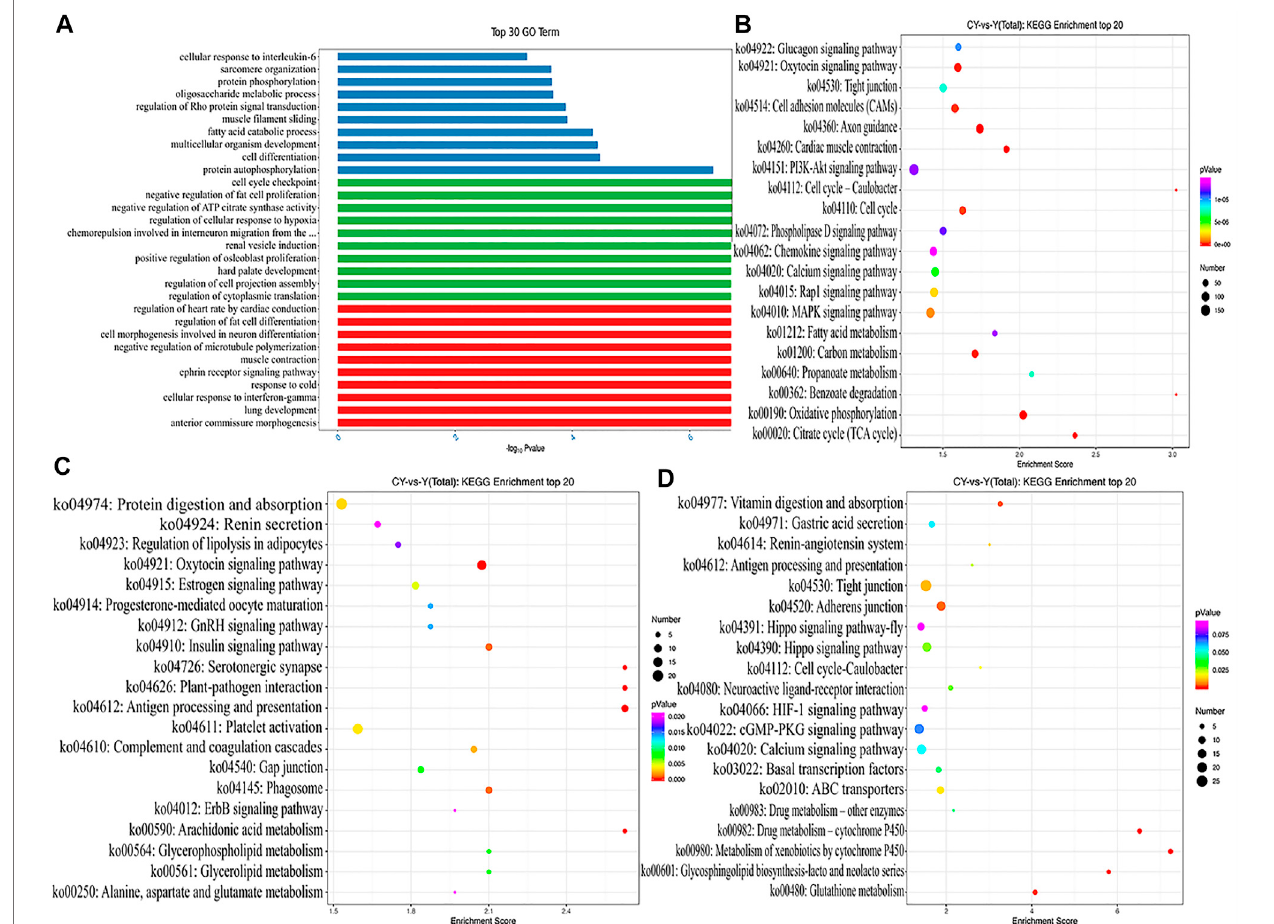
FIGURE3 | (A) GOanalysiswiththe top 10 enrichmentbiological processes for DEMs, DELs targets, and DECs host genes between cattle-yaks and yaks. KEGG analysis with the top 20 KEGG enrichment pathways for DEMs (B) , DELs target genes (C) , and DECs host genes (D) between the cattle-yaks and yaks.